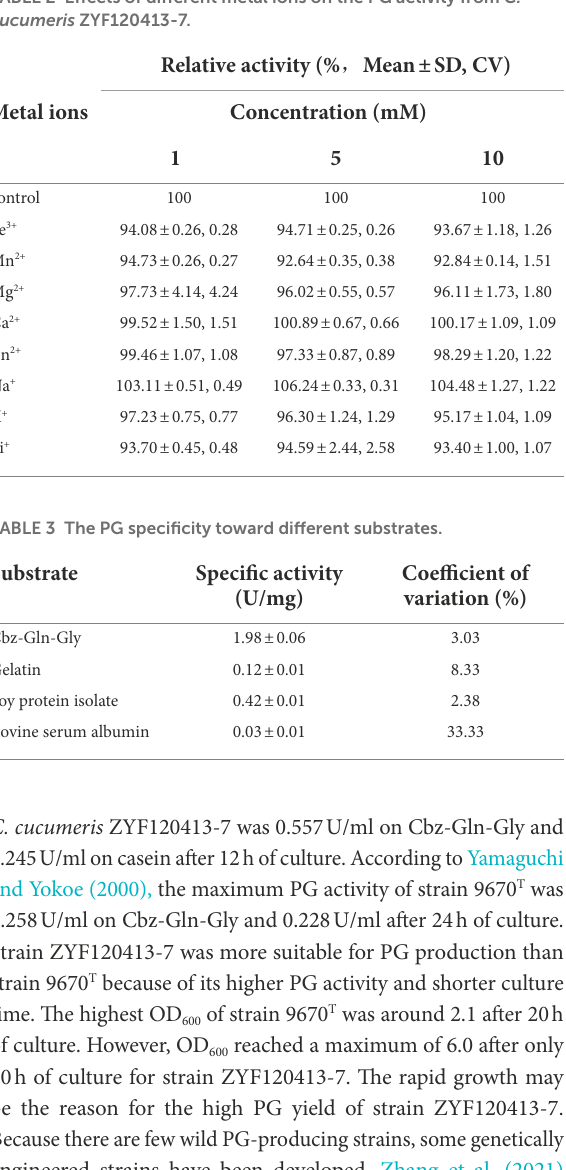
TABLE 2 Effects of different metal ions on the PG activity from C. cucumeris ZYF120413-7.